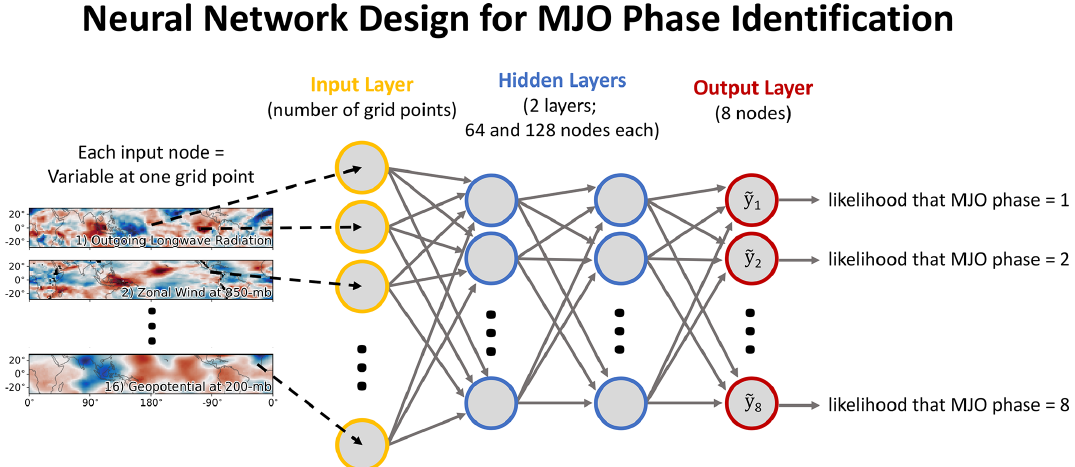
Figure 3. Schematic for the neural network used in this study. The first layer ingests vectorized input images, with two subsequent hidden layers (the first with 64 nodes and the second with 128 nodes) and an output layer of 8 nodes that correspond to the eight phases of the MJO. A separate neural network is trained for each calendar week of the